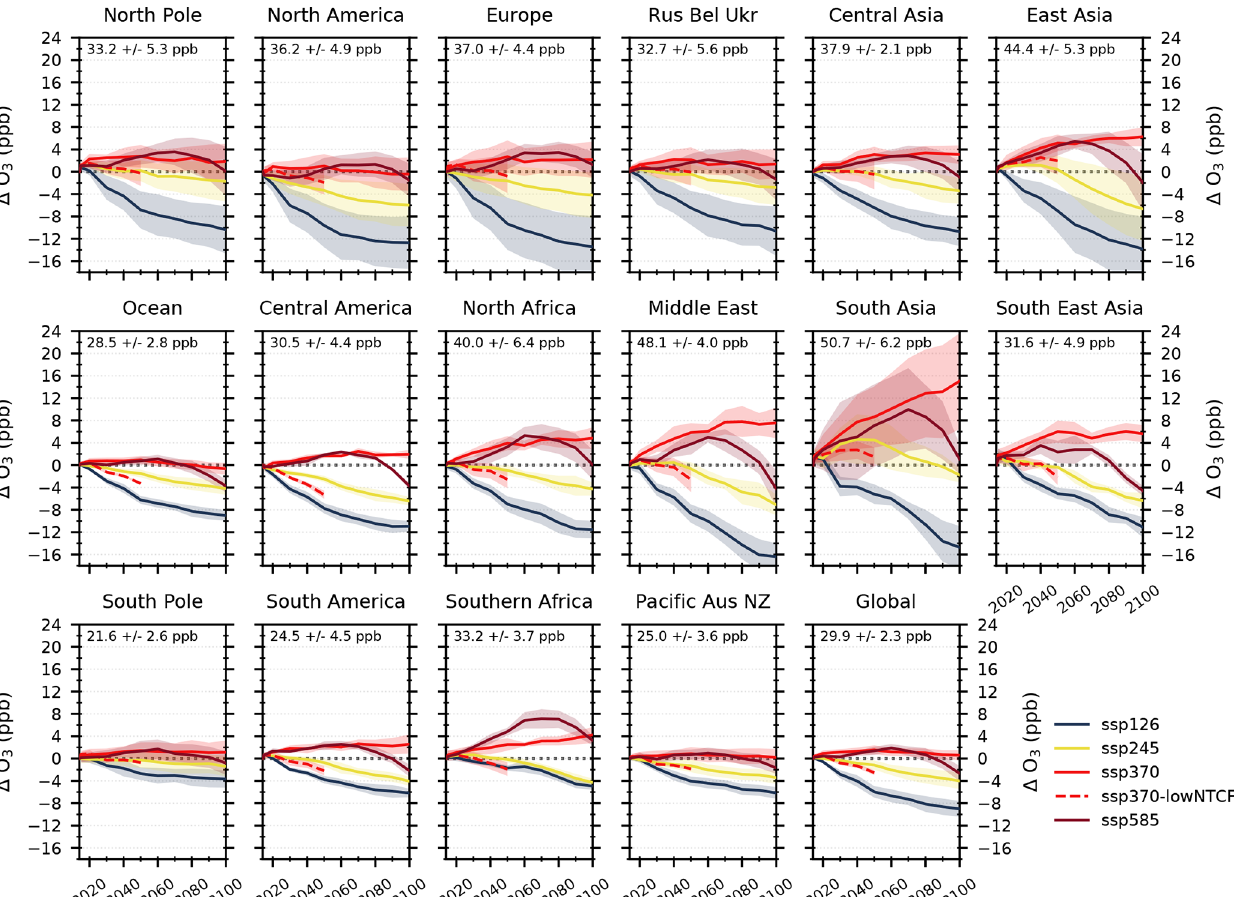
Figure 11. Future global and regional changes in annual mean surface O 3 , relative to 2005–2014 mean, for the different SSPs used in CMIP6. Each line represents a multi-model mean across the region, with shading representing the ± 1SD of the mean. See Table 1 for details of models contributing to each scenario. The multi-model regional mean value ( ± 1SD) for the years 2005–2014 is shown in the top left corner of each